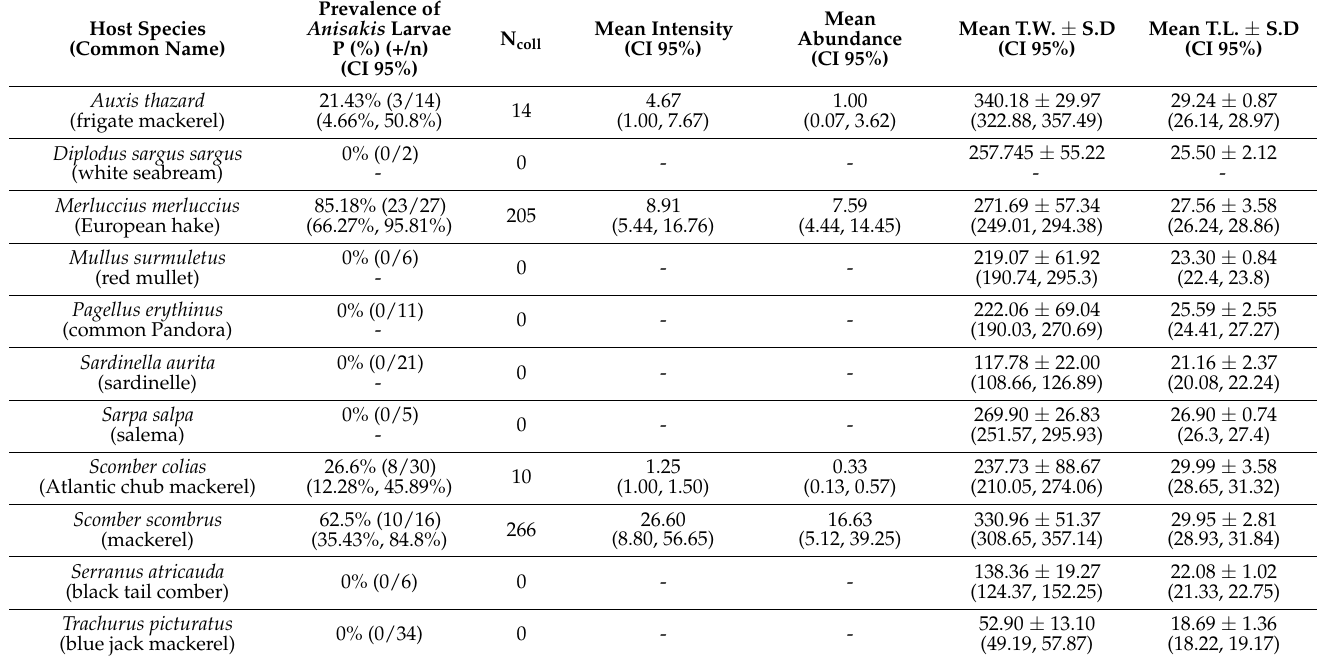
Table 1. Record of measurements, weight and body length of fish examined during October